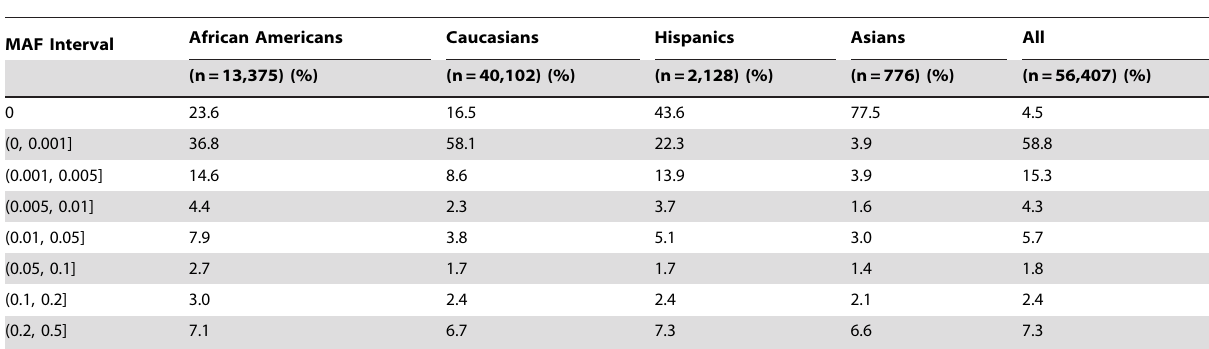
Table 1. Exome chip minor allele frequency distribution by